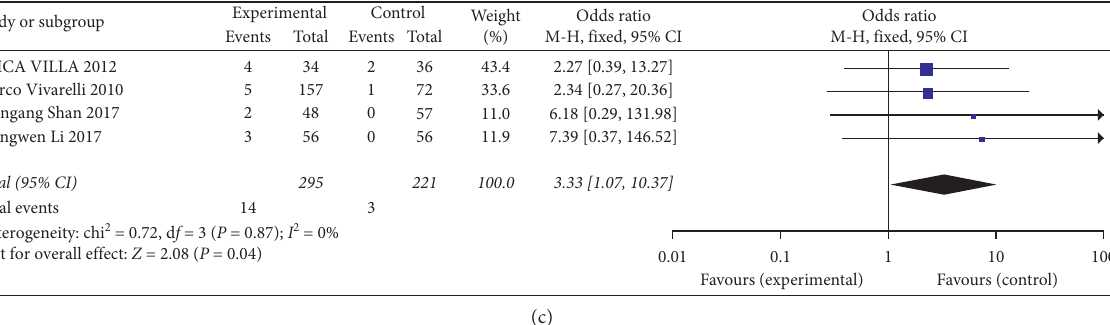
Figure 6: Effect and safety of prophylactic anticoagulant: (a) appearance of new thrombosis; (b) subgroup analysis of new thrombosis; (c) bleeding events.